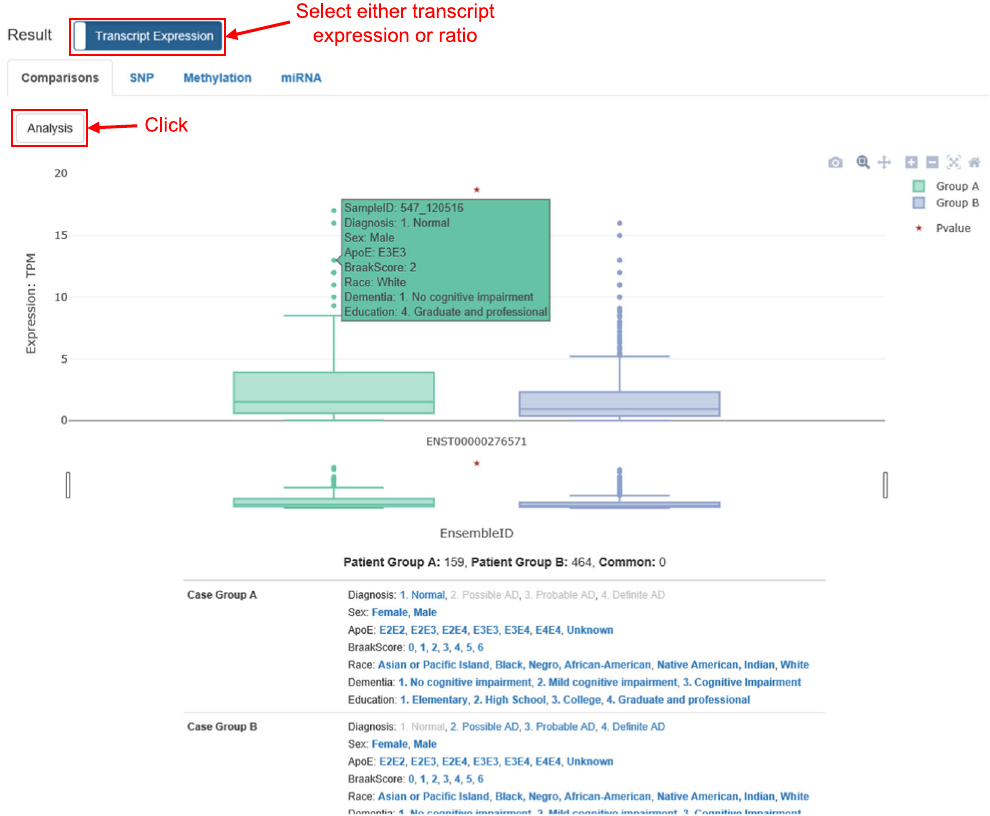
Fig. 4 Comparisons tab of ADAS-viewer “ Transcript Expression ” analysis results. This example compares expression of ENST00000276571 between normal and AD